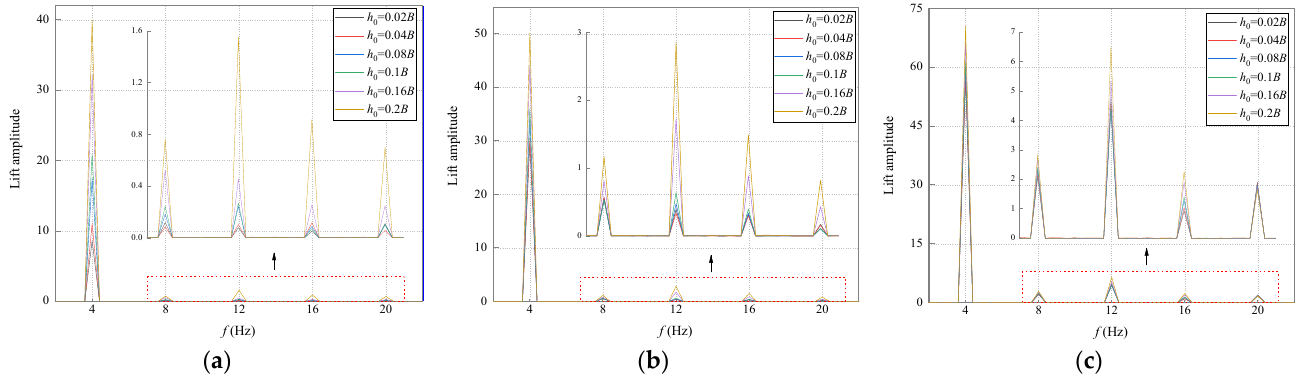
Figure 10. Aerodynamic lift spectrum under different coupled amplitude. ( a ) Pitching amplitude α 0 = 2 ◦ ( b ) Pitching amplitude α 0 = 8 ◦ ( c ) Pitching amplitude α 0 = 16 ◦ .